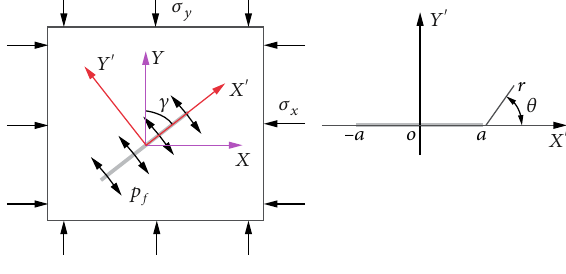
Figure 4: Stress state of a propagating